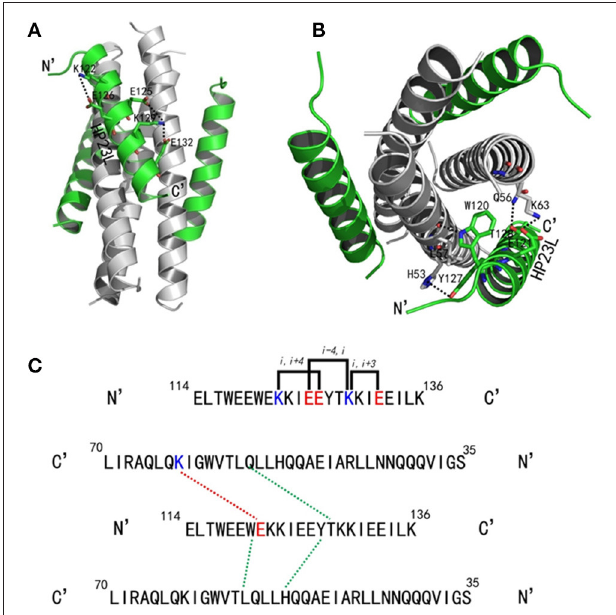
FIGURE 2 | Salt-bridges and hydrogen bonds in 6-HB structure of HP23L/N36. (A) A ribbon model of the 6-HB structure formed by HP23L/N36. The N36 trimer is colored in gray and the HP23L peptides are colored in green. The charged residues involving ion pair formation on the HP23L helix are shown as stick models with labels. The salt-bridges formed between charged residues are indicated in dashed lines. (B) A ribbon model of the 6-HB structure formed by HP23L/N36. The N36 trimer is colored in gray and the HP23L peptides are colored in green. The residues involving the formation of ion pair and hydrogen bonds between HP23L and N36 trimer are shown as stick models with labels. The salt-bridge and hydrogen bonds formed between residues are indicated with dashed lines. (C) Sequence illustration of salt-bridges and hydrogen bonds in the 6-HB of HP23L/N36. The upper indicates the intrahelical salt-bridges of HP23L in solid black lines, while the positively charged lysine and the negatively charged glutamic are respectively marked in blue and red. The lower indicates a single HP23L peptide interacting with two N36 helices, in which the dashed red line indicates a